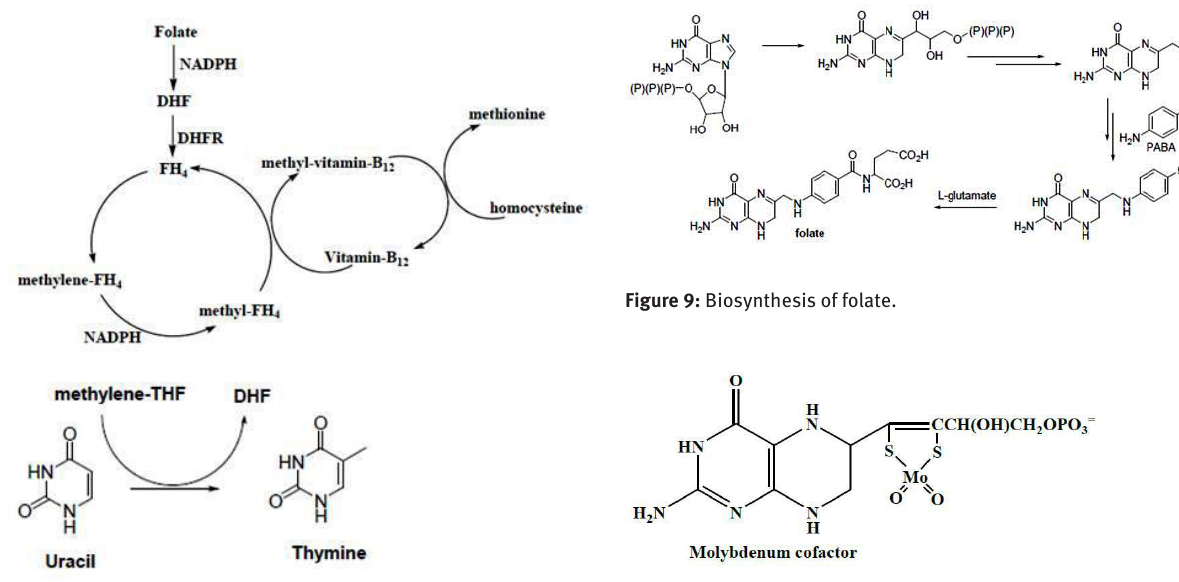
Figure 10: Molybdenum cofactor (Moco)